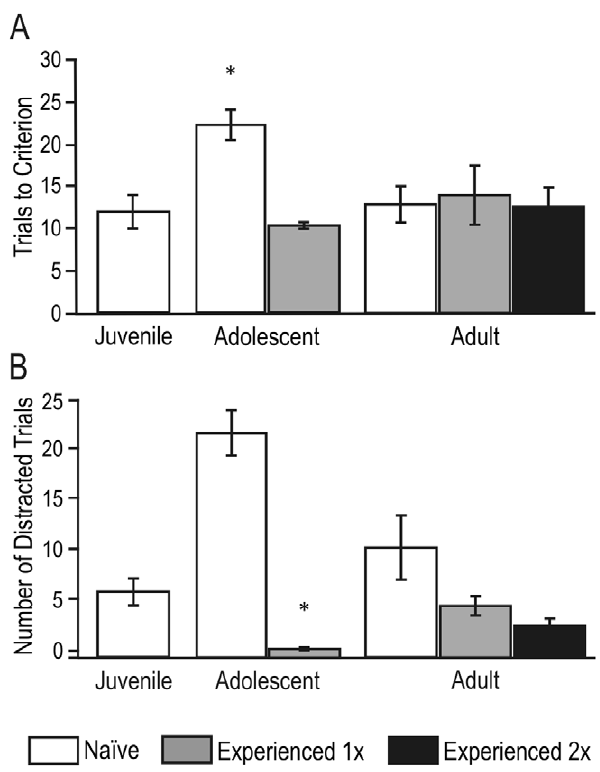
Figure 2. Effects of previous experience. A) Average number of trials ( 6 SE) to reach criterion on an olfactory-guided associative learning task for animals that were naı¨ve to the task (white bars), and for animals that had previously experienced the associative learning task once (gray bars) or twice (black bars). While naı¨ve adolescent rats required significantly more trials to learn the odor association than